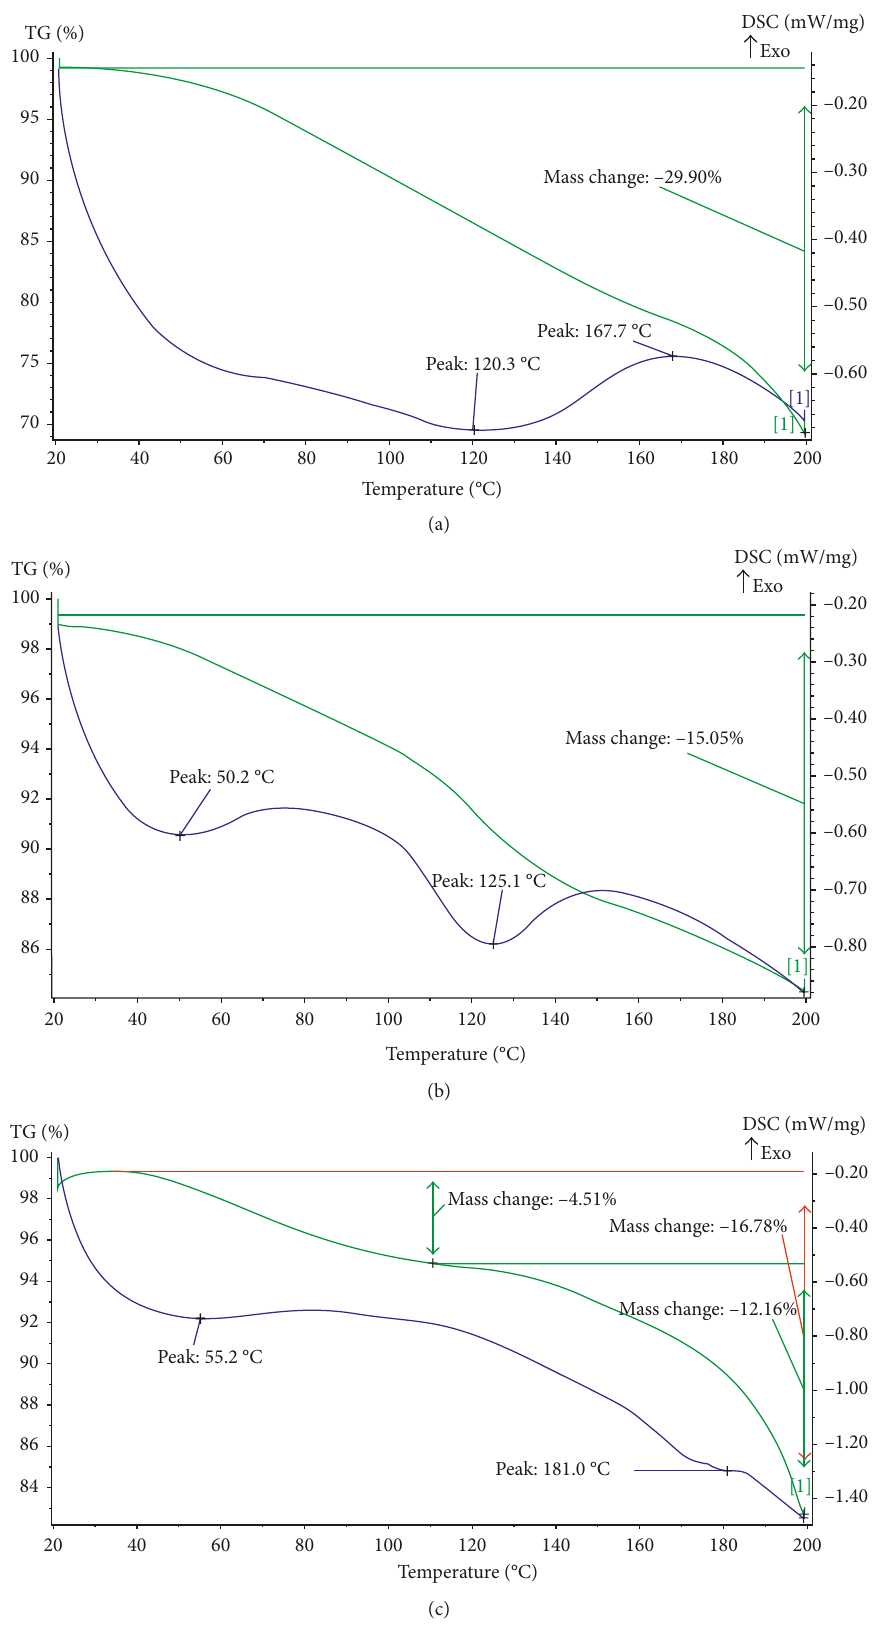
Figure 5: Thermograms of DP (a), OP (b), and CP (c). DP: date fruit paste; OP: olive fruit paste; CP: carob fruit